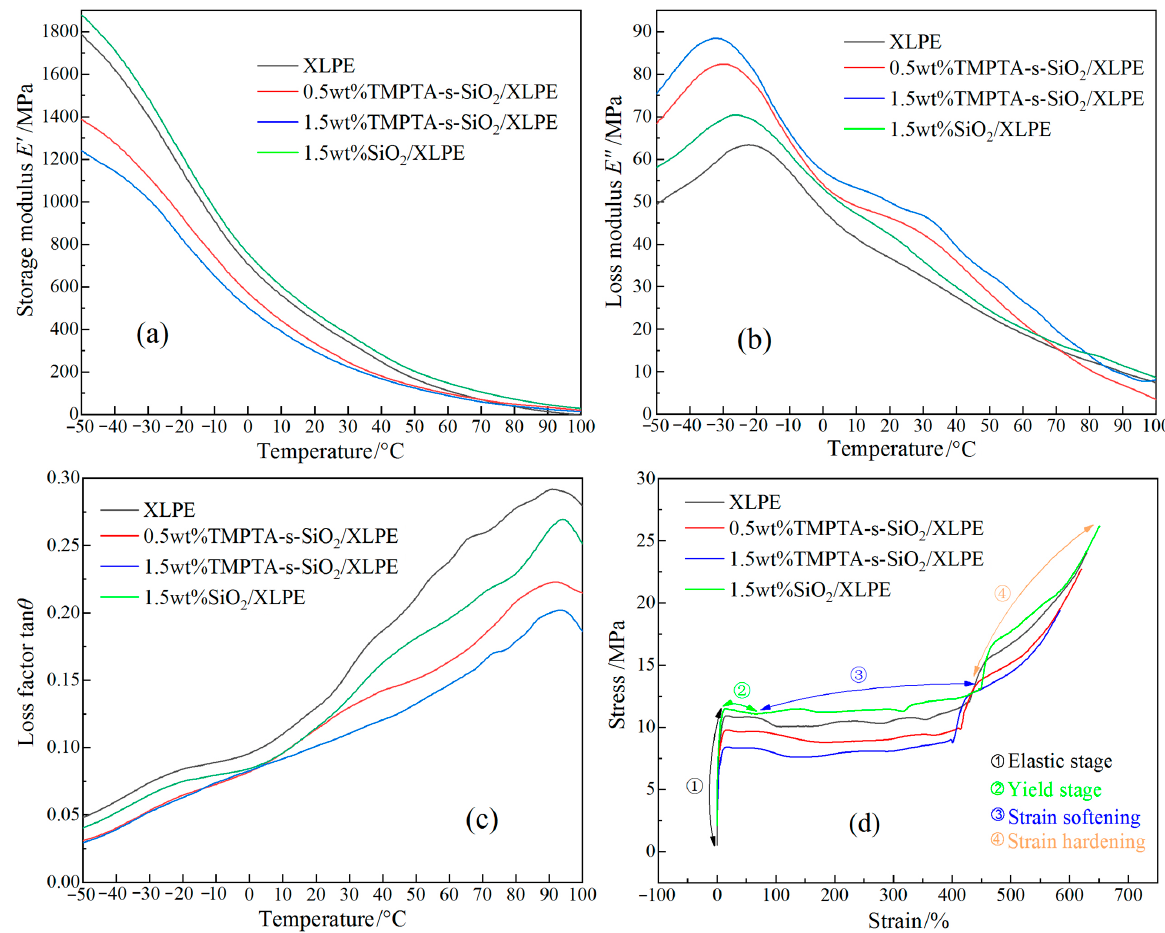
Figure 9. Dynamic thermo-mechanical spectra: ( a ) storage modulus, ( b ) loss modulus ( c ) loss factor, and ( d ) stress-strain characteristics of XLPE and its nanocomposites.